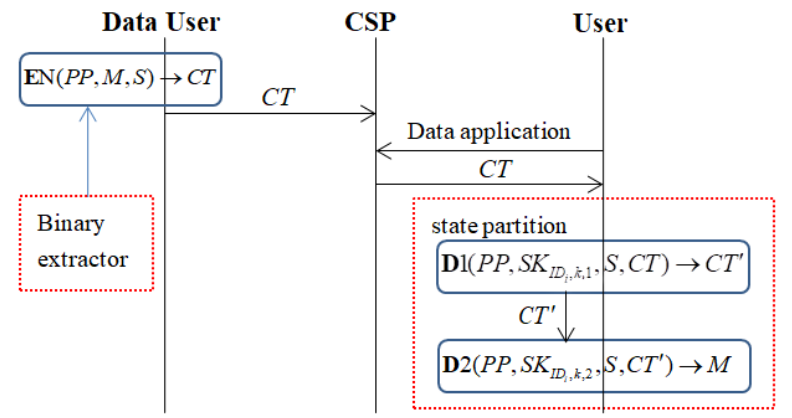
Figure 2. The encryption and decryption system of our scheme.